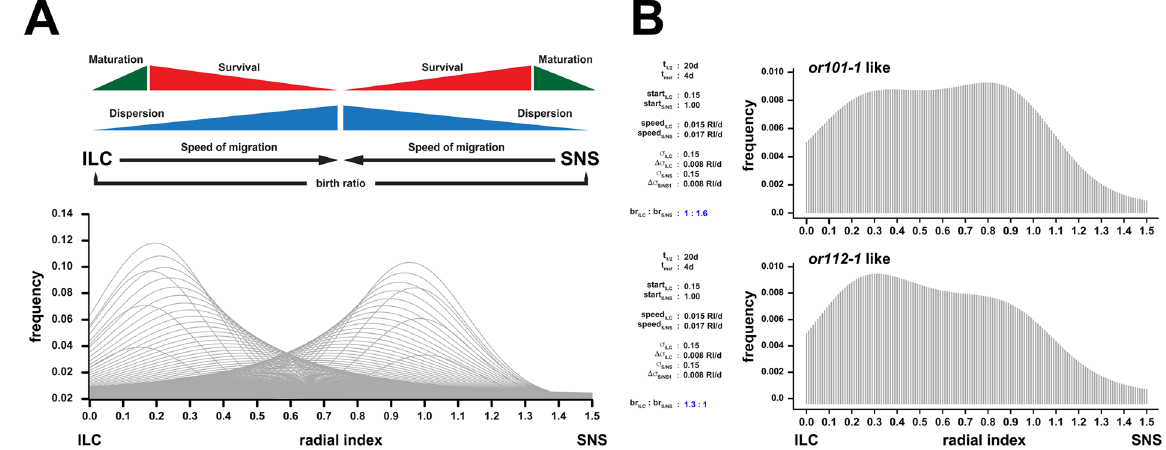
Figure 8. A mathematical model for OR expression profiles. ( A ) Architecture of the mathematical model developed to describe the generation of specific OR gene expression patterns in the zebrafish OE. The model function generates OSN distribution profiles for consecutive days based on their time to maturation, half life, speed of positional shifts across the OE, increase in dispersion ( σ ), and the bias in generation at the interlamellar curve (ILC) and sensory/nonsensory border (SNS). The resulting OR profile is equivalent to the positional sum of the timed distributions. The full R code of the model can be found in the Supplementary Material. ( B ) Model output for two different parameter sets to model or101 - 1 - (top) and or112 - 1 -like (bottom) distributions, which represent the two extremes analysed in this study. The or101 - 1 -like profile can be changed into an or112 - 1 -like distribution by adjusting the bias in OSN generation at the ILC and SNS (br ILC : br SNS : birth ratio ILC: SNS, blue). A more detailed description of the model output and its dependency on the various parameters is given in the Supplementary